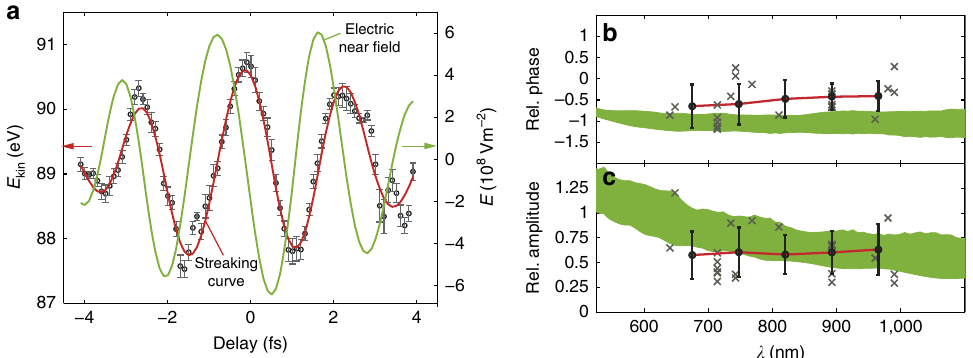
Figure 4 | Extraction of the electric near field and response function. ( a ) Reconstruction of the local electric near field (green line) and vector potential (red line) at the nanotaper surface from the measured streaking curve (symbols). The error bars indicate 95% confidence intervals of the Fermi fit. Retrieved wavelength-resolved ( b ) relative phase shift and ( c ) amplitude obtained from different measurements. Data points are shown as crosses, whose positions are given by the spectral sampling of the different measurements. Different measurement sets do not necessarily cover the same number and size of delay scans in the streaking spectrographs, which translates into a different spacing and number of data points after Fourier transformation. Only data points in the wavelength range covered by the input NIR pulses, that is, from 500 to 1,100nm, are displayed. Data points outside this range are a consequence of over-sampling in the time domain, and have a vanishingly low spectral amplitude. Mean values (symbols) have been obtained by linearly interpolating the retrieved linear response from the individual measurements. Error bars represent the s.d. The green shaded areas show the range of phase shifts and relative amplitudes expected from the electric field calculations, considering emission from different points on the surface from the tapered